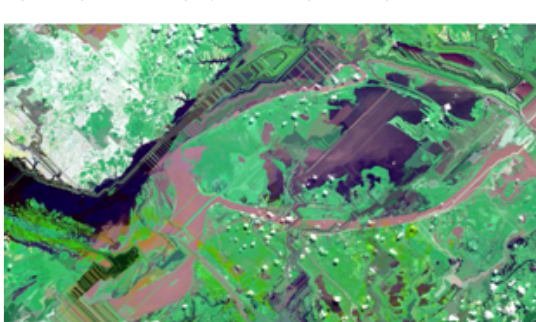
Figure 7 | Full color or human view shows generative redesign of landscape